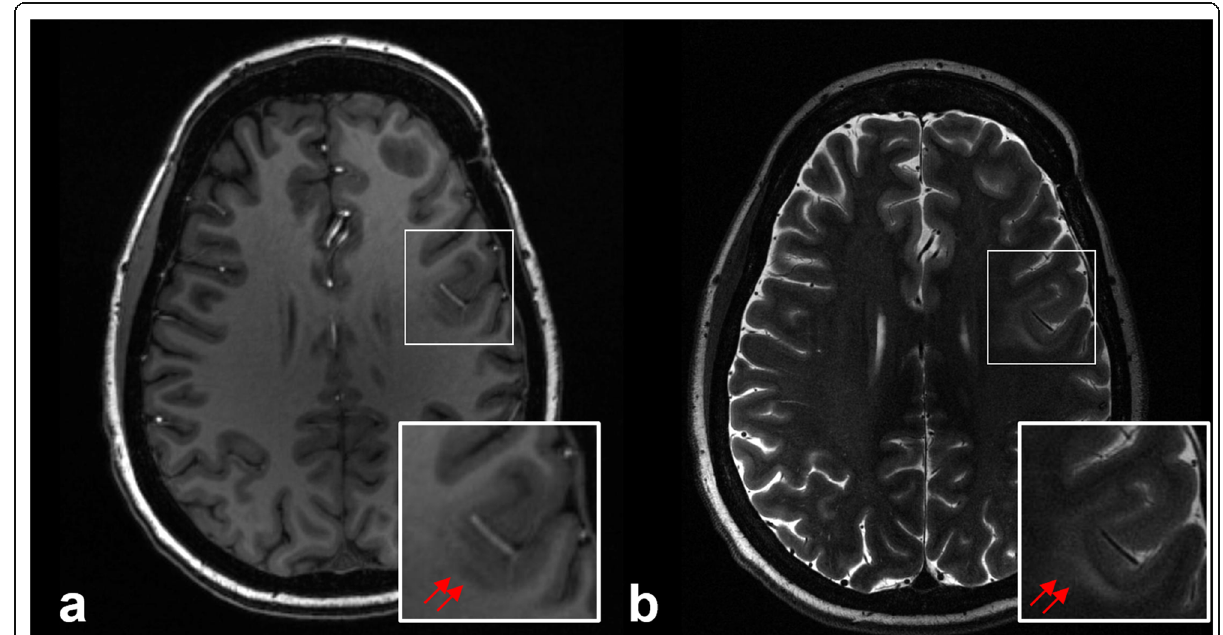
Fig. 2 Anatomical delineation of focal cortical dysplasia at 7 T. Axial T1-weighted ( a ) and T2-weighted ( b ) images acquired at 7 T demonstrate blurring of the gray-white matter junction (double arrows), abnormally thick malformed cortex, and an indistinct cortical ribbon in the left inferior frontal gyrus, consistent with focal cortical dysplasia. There is T2 hyperintensity in the subjacent white matter reflecting the white matter component of the